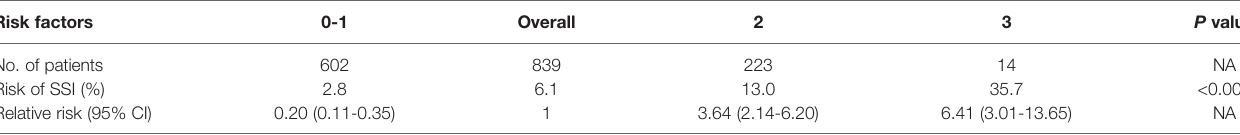
NA, not applicable; SSI, surgical site infection; CI, con fi dence interval.